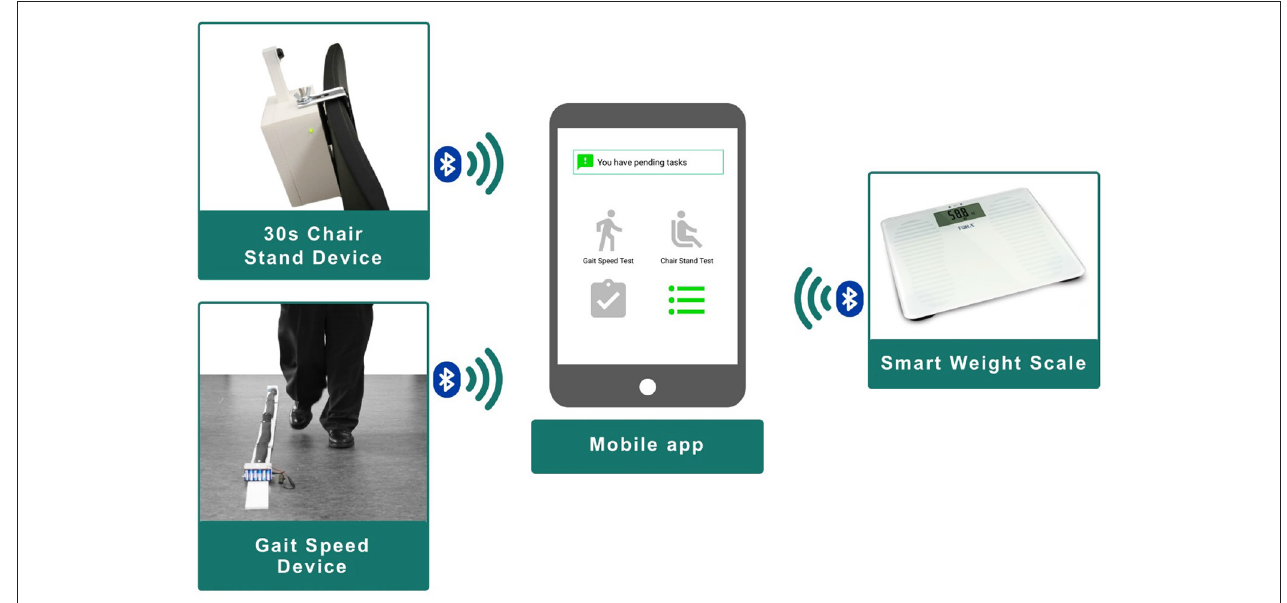
FIGURE 2 | Home monitoring